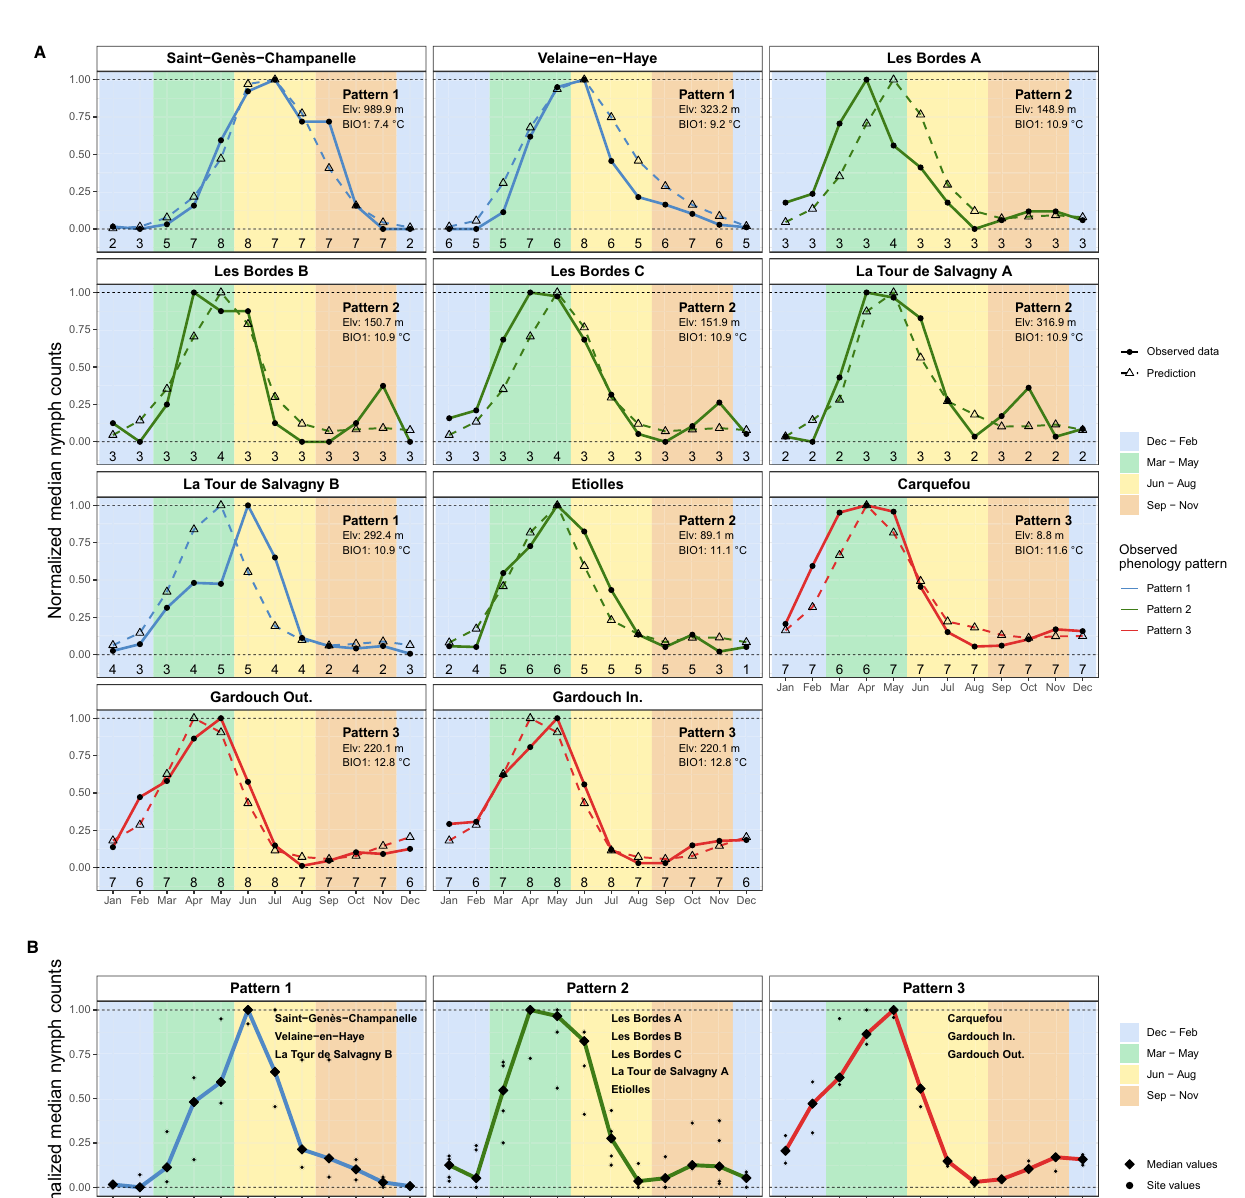
Figure 6. Phenological patterns of I. ricinus nymph activity observed at 11 sampling sites: ( A ) observed and predicted normalized monthly median nymph counts of each sampling site. The value of 1 indicates the maximum nymph activity (peak), while the value of 0 indicates the absence of nymph activity. Line types distinguish between the observation (solid) and prediction from the best-fitted model (dashed). Line colours indicate different phenological patterns of the observed data: Pattern 1, a unimodal pattern with a summer peak and a winter pause (blue); Pattern 2, a bimodal pattern with a greater activity peak in spring and a smaller peak in autumn (green); Pattern 3, a unimodal pattern with a spring peak without winter pause (red). Text annotations demonstrate mean elevation above the sea level mean elv (m) and average annual temperature BIO 1 temp (°C). Numbers at the bottom represent the number of observations of each month throughout the study period; ( B ) normalized monthly median nymph counts observed at each site (circle) and the overall trend of each phenological pattern (diamond and line). The overall trend of each pattern was determined using the medians of the values from all sites that showed that pattern, as indicated by text annotations. Background colours indicate meteorological seasons of the temperate areas of northern hemisphere: Spring, 1st March